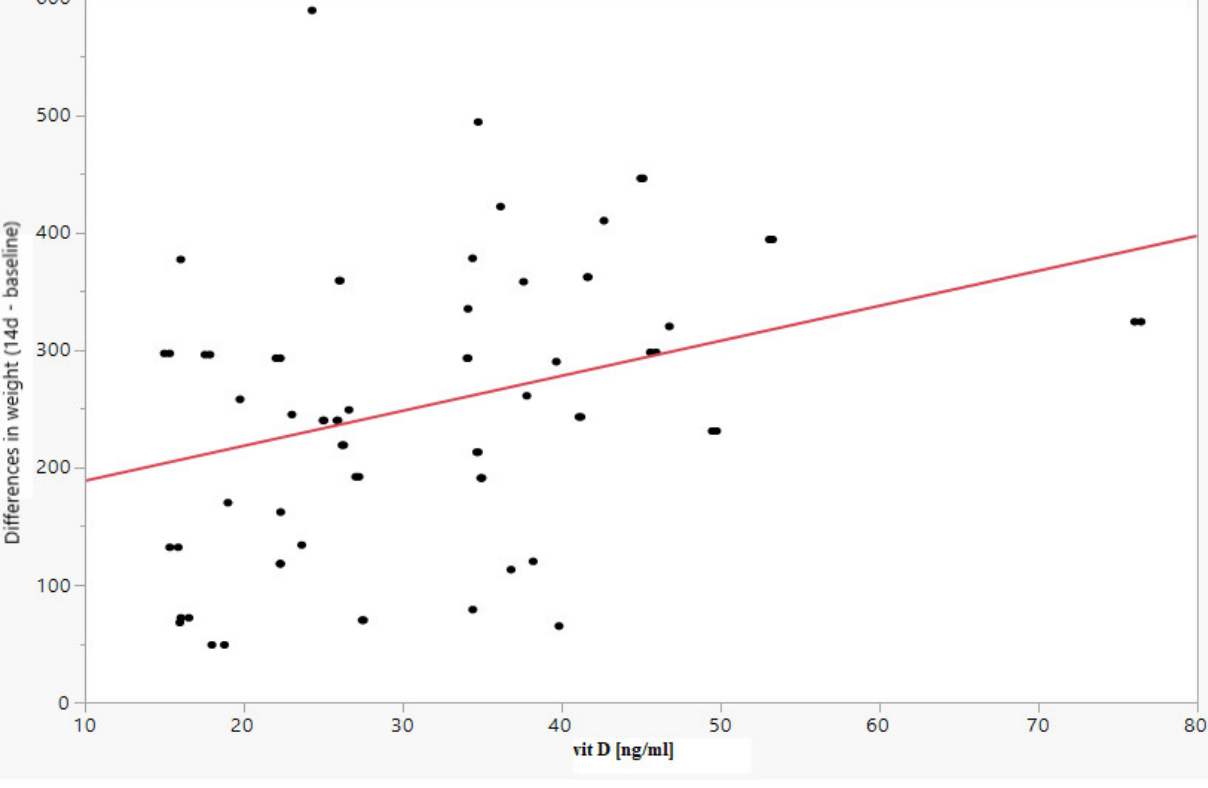
Figure 3. Increase in fetal weight on Day 14 of observations depending on the vitamin D level.